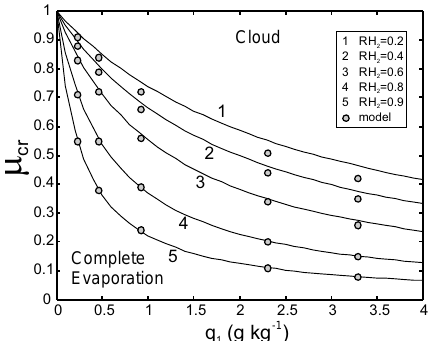
Figure 2. Dependence of critical mixing fraction µ cr vs. mixing ratio q 0 calculated from Eq. (7). Circles indicate modeled points. The calculations were performed for T = 0 ◦ C and H =